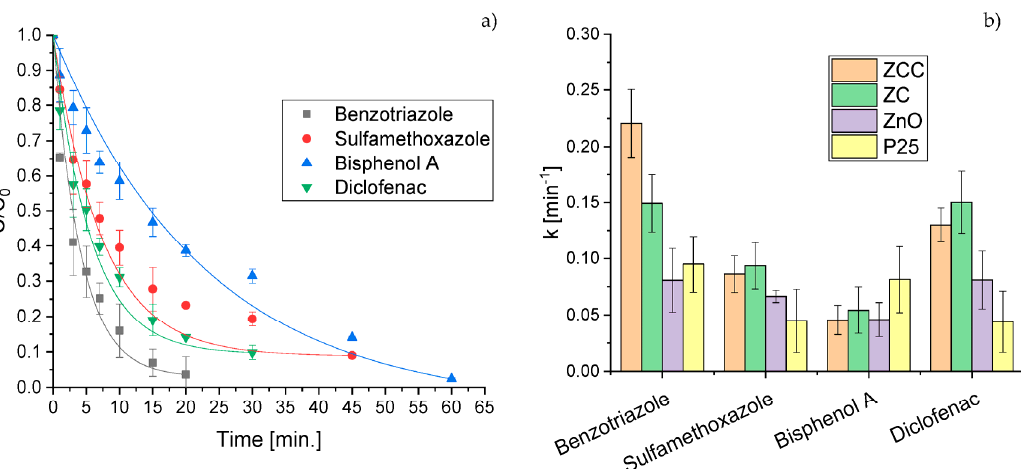
Figure 2. Degradation profiles of CECs obtained using ZCC photocatalyst ( a ) and kinetic constants estimated for CECs abatement reaction ( b ).